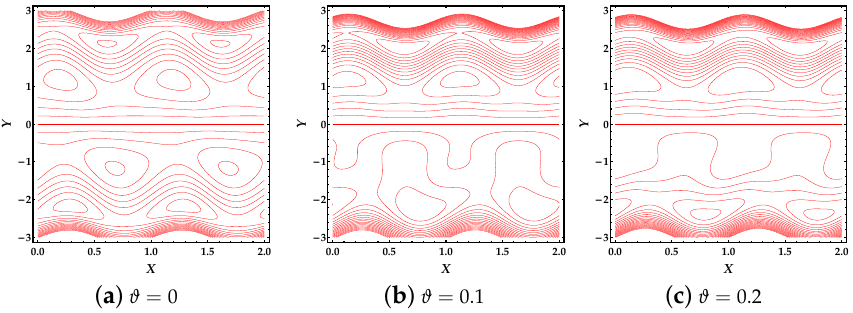
Figure 8. Streamline mechanisms against multiple values of ϑ